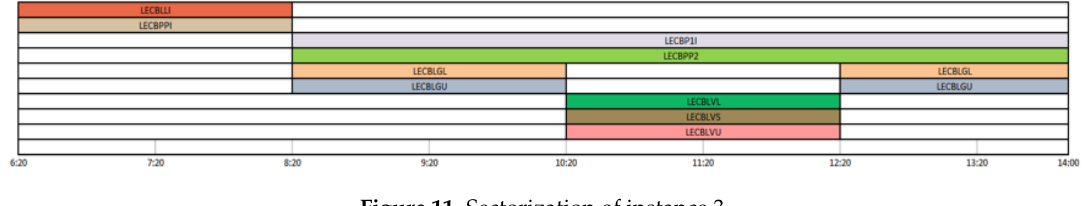
Figure 11. Sectorization of instance